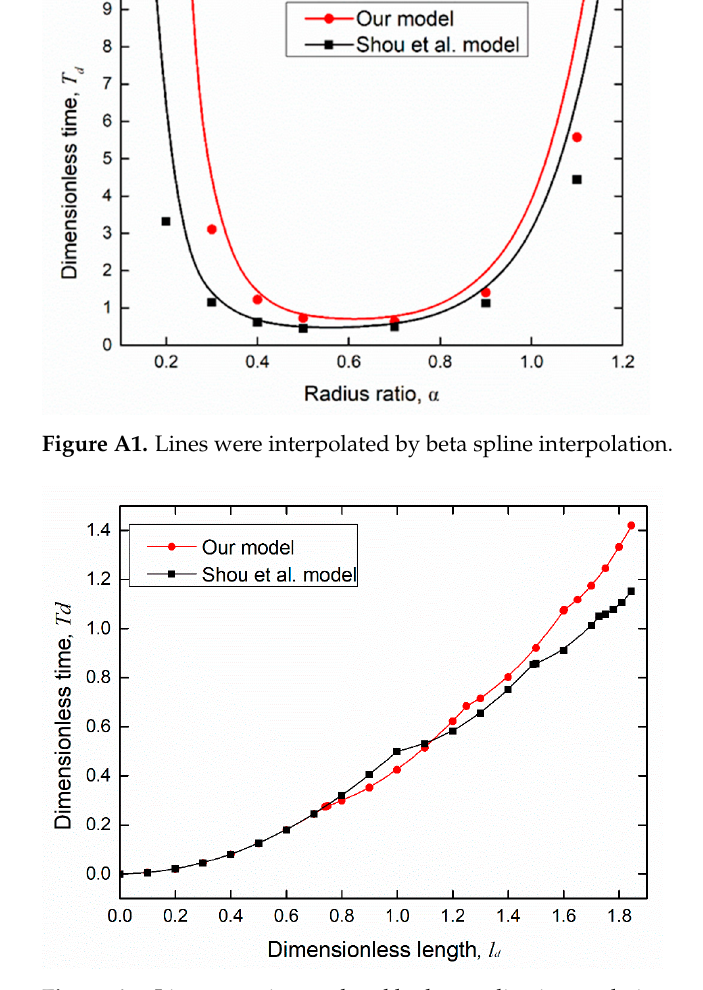
Figure A2. Lines were interpolated by beta spline Figure B2. Lines were interpolated by beta spline interpolation.